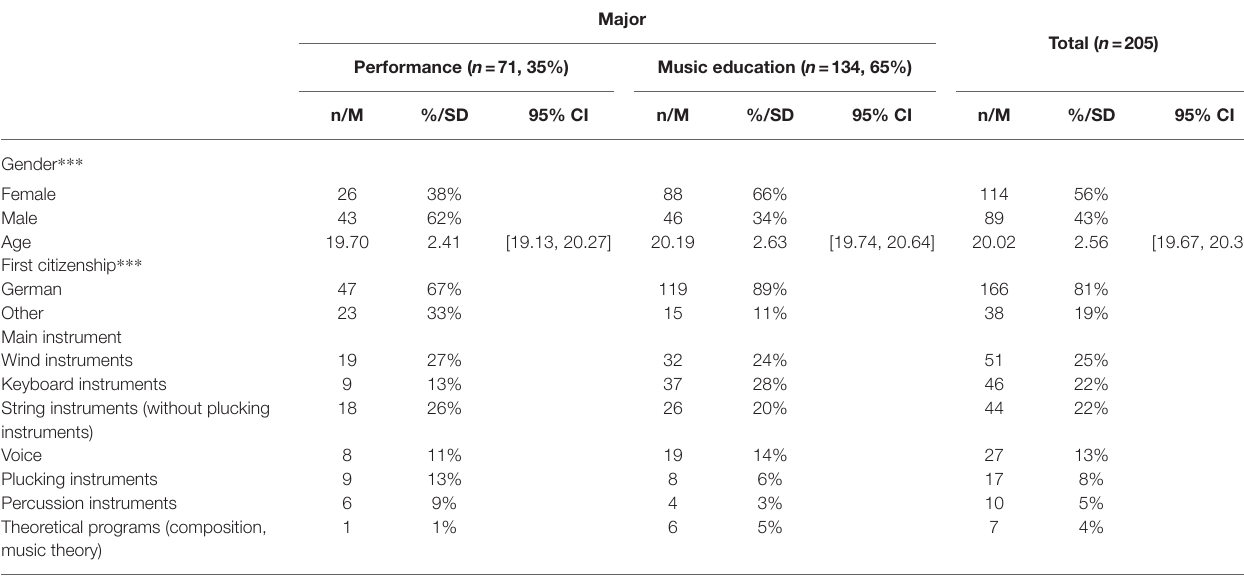
TABLE 1 | Sample characteristics (performance majors and music education